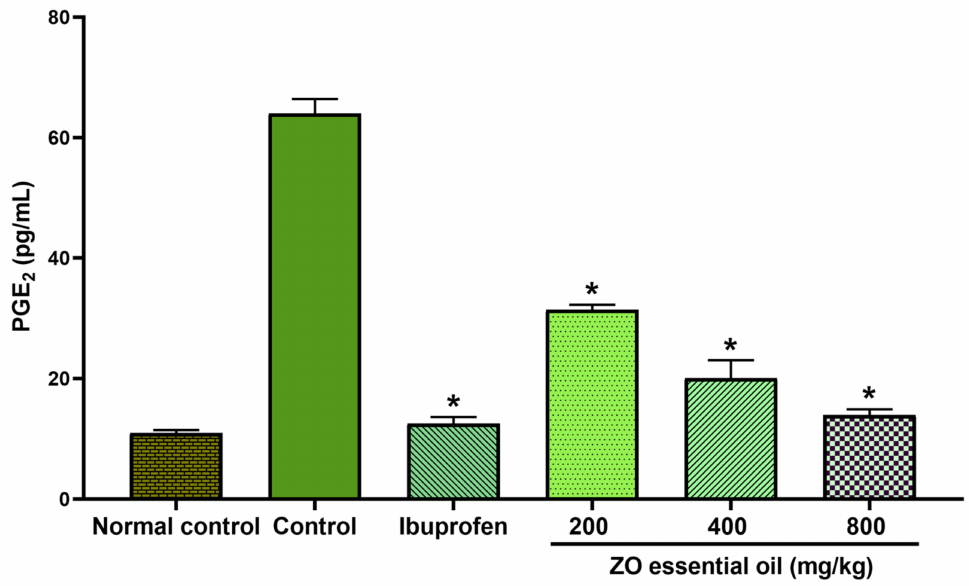
Figure 6. Measurement of PGE 2 concentration in the serum of rats, pretreated with vehicle (0.9% saline), ibuprofen (100 mg/kg), or ZO essential oil at different doses, at 6 h after carrageenan. Data represent the mean ± SEM ( n = 6). * Denotes significant differences ( p < 0.05) compared to the control